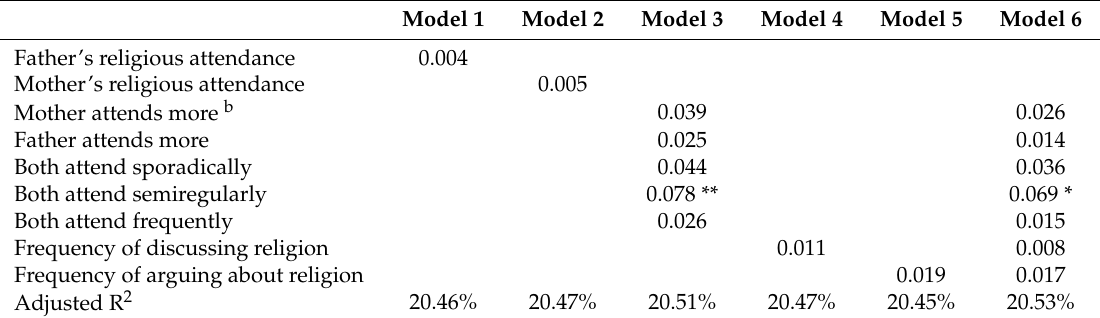
Table 2. Unstandardized coefficients predicting children’s self-control (teachers’ ratings, n = 10,720) a .